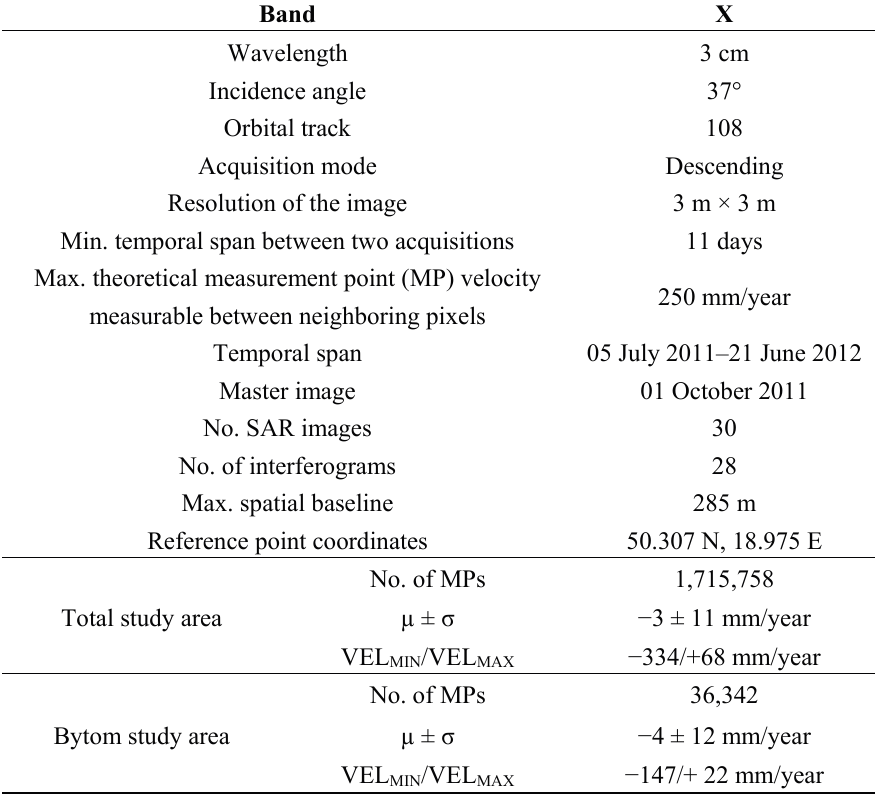
Table 3. Main characteristics of the Synthetic Aperture Radar (SAR) dataset and the SqueeSAR TM results (after ramp